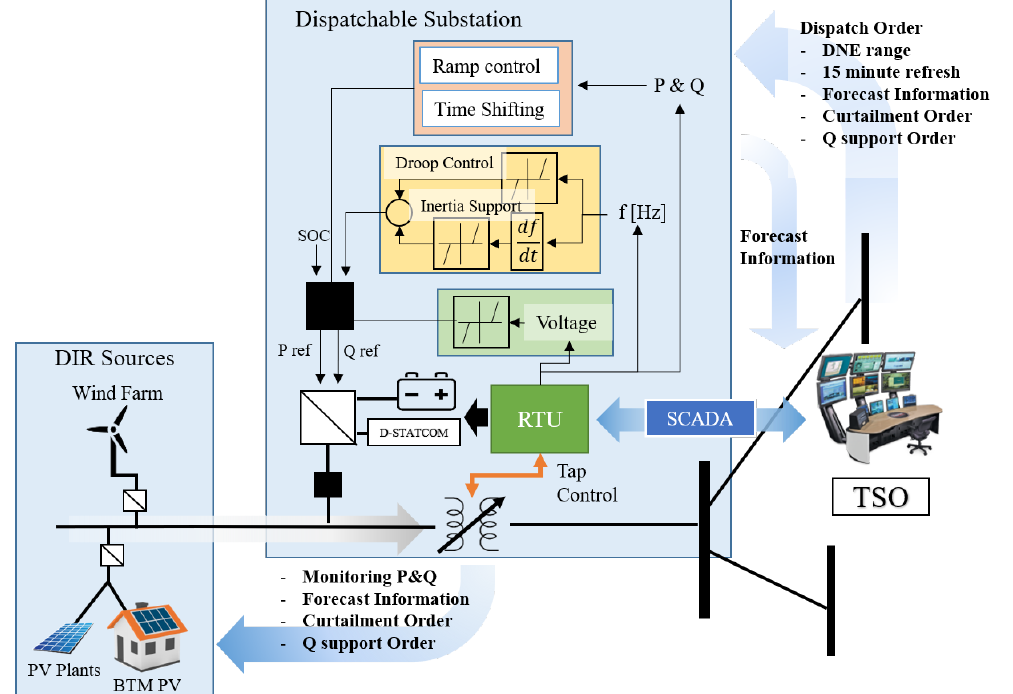
Figure 1. Operation of dispatchable